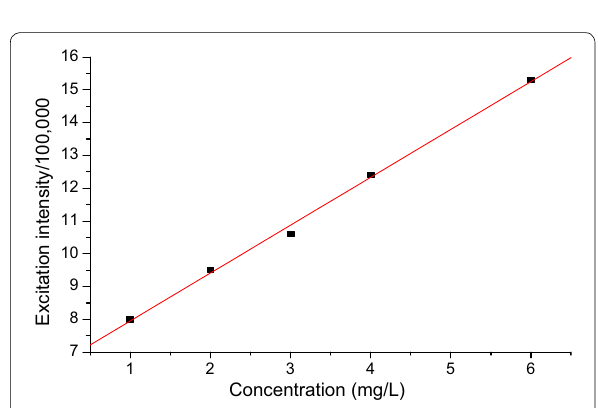
Fig. 5 Graph of concentration vs maximum fluorescence excitation intensity for theobromine standard dissolved in water